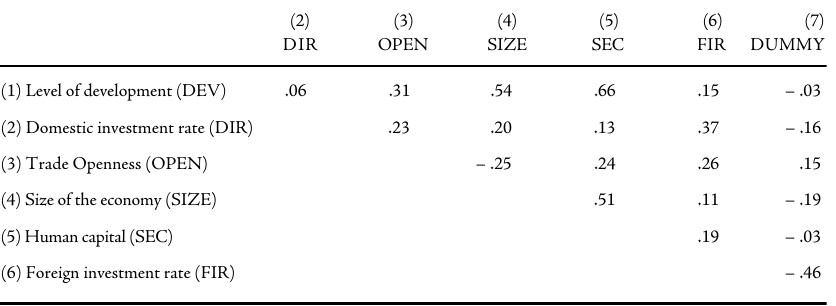
Table A-1d – Bivariate Correlations (Pearson’s r-coefficients) for n=63 LDCs,